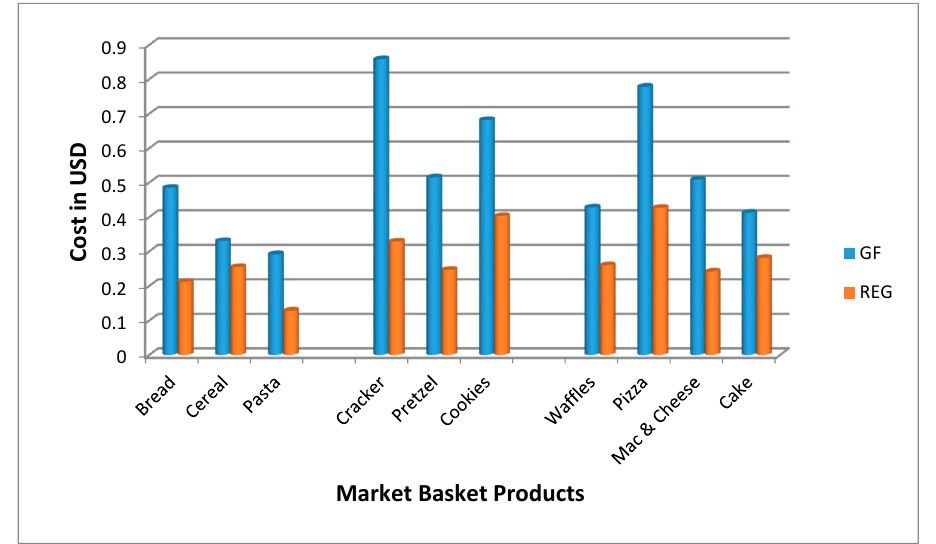
Figure 1. Cost of gluten free (GF) products in 2016 compared to wheat-based products (REG) ( p = < 0.001) by market basket category in price per ounce.